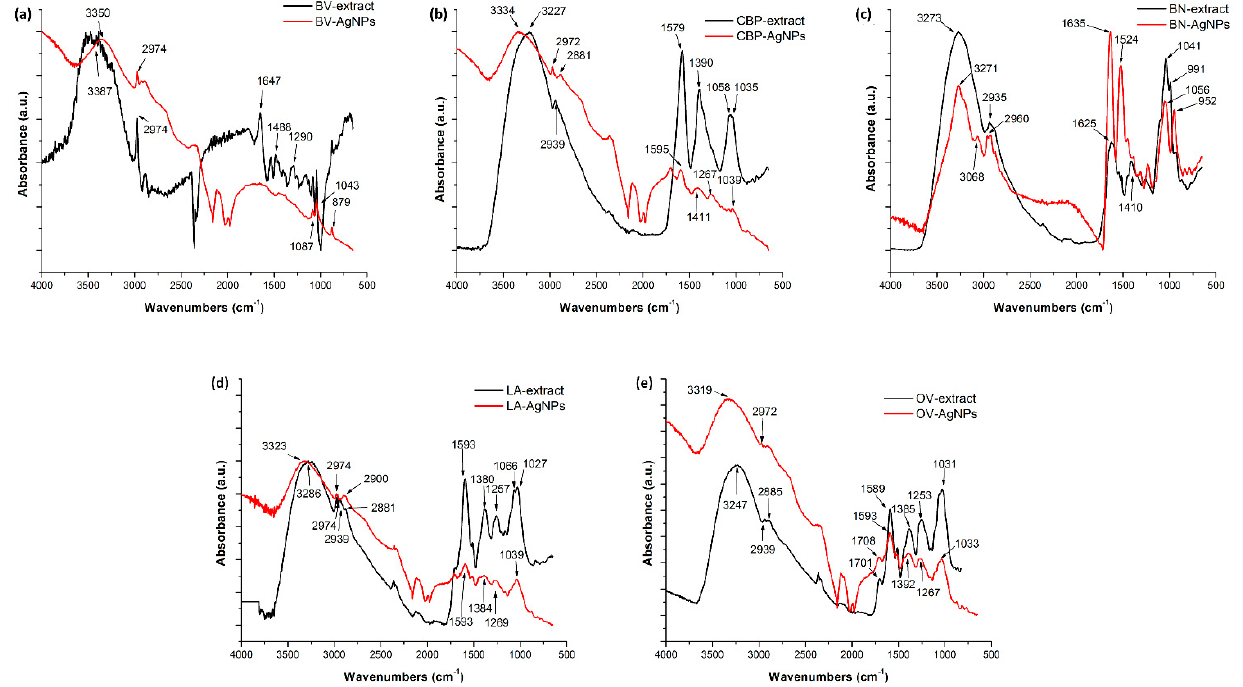
Figure 5. Attenuated total reflectance (ATR)-FTIR absorption spectra of plant extracts and synthesised AgNPs from 5 mM AgNO 3 , ( a ) BV-AgNPs, ( b ) CBP-AgNPs, ( c ) BN-AgNPs, ( d ) LA-AgNPs and ( e ) OV-AgNPs.